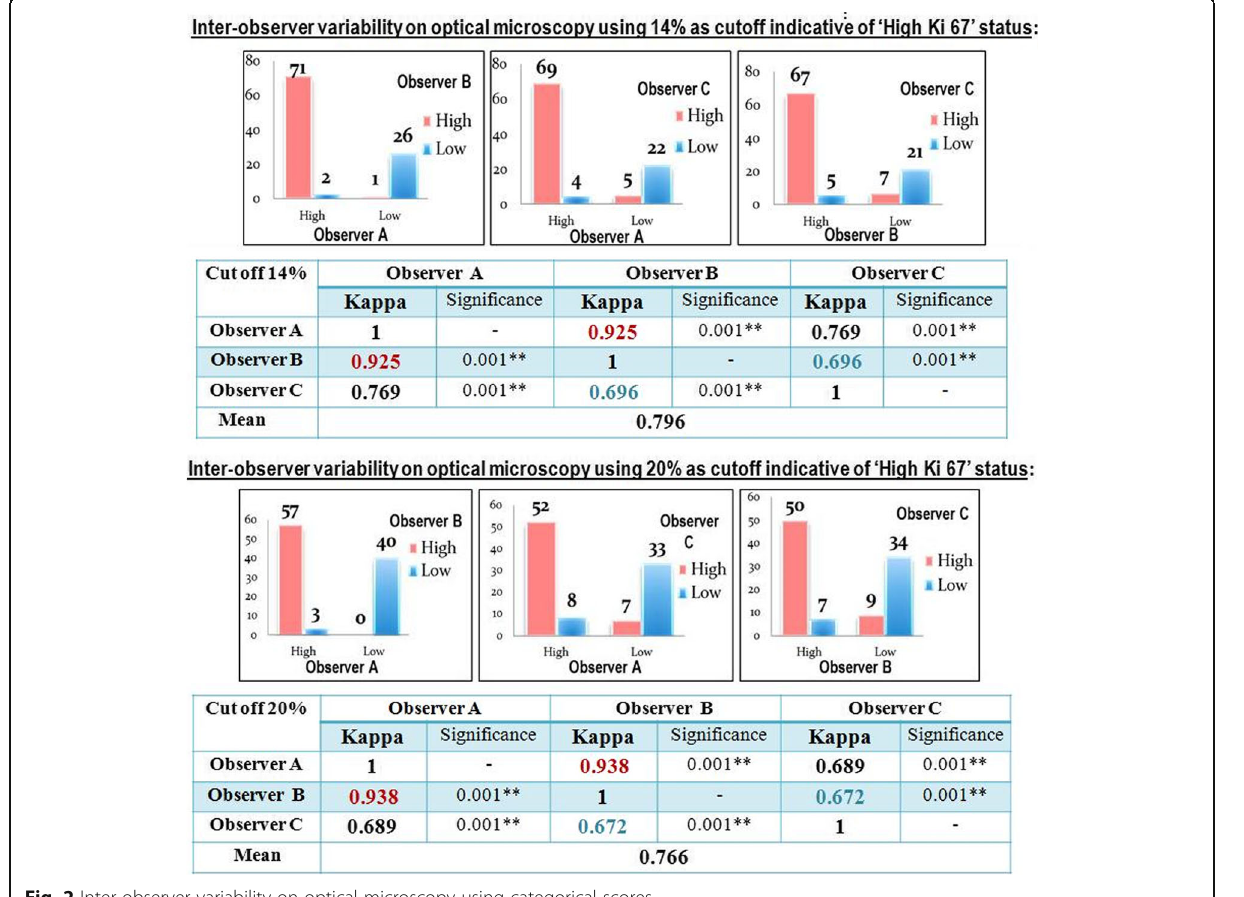
Fig. 2 Inter-observer variability on optical microscopy using categorical